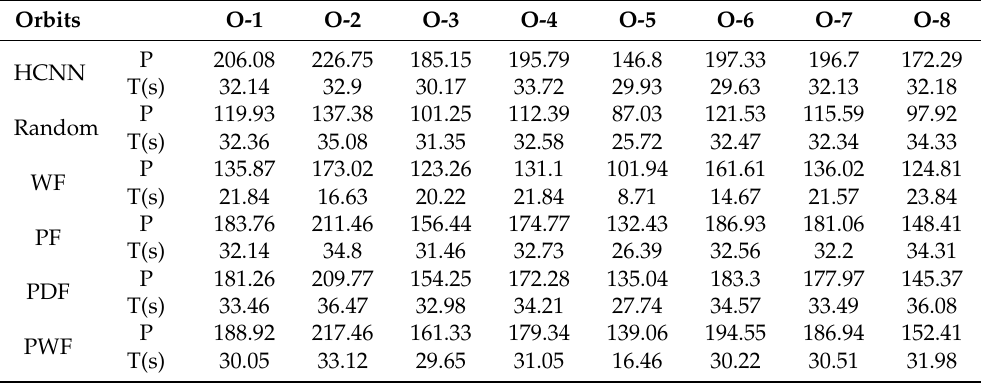
Table 9. Experimental results for the single-orbit scenarios with 100 tasks.